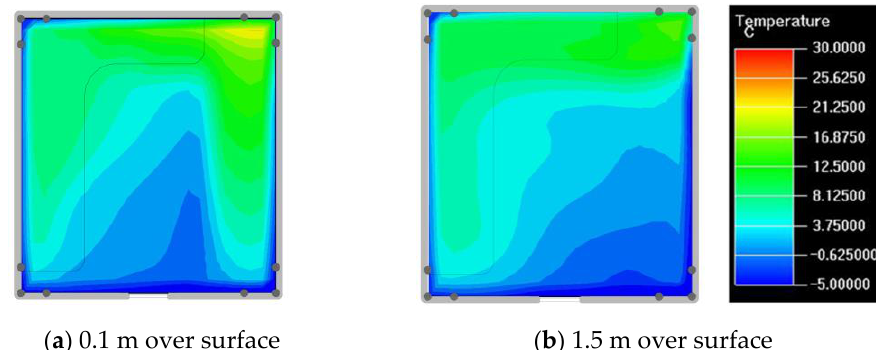
Figure 2. The indoor temperature of F10.